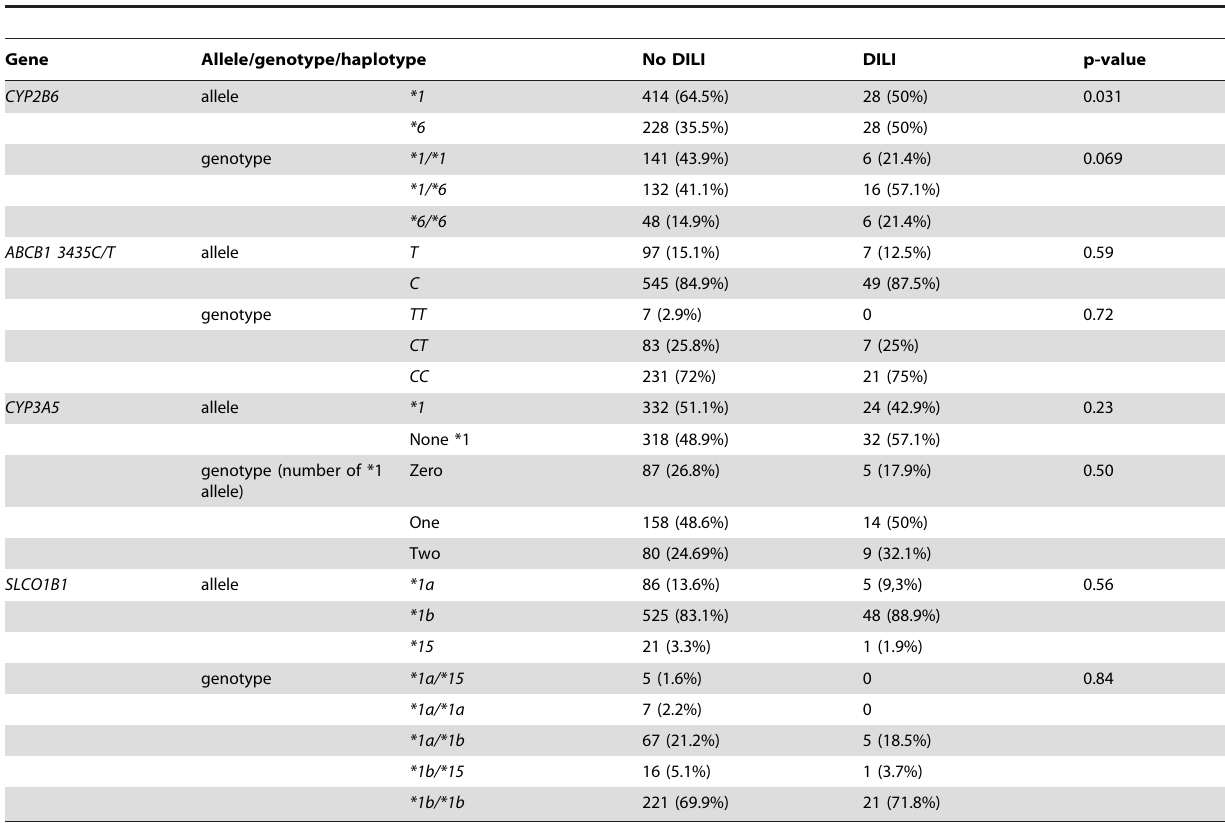
Table 2. Comparisons of CYP2B6 , CYP3A5 , NAT2 , SLCO1B1 and ABCB1 variant alleles and genotype/haplotypes between DILI non- DILI cases among HIV patients with or without tuberculosis.